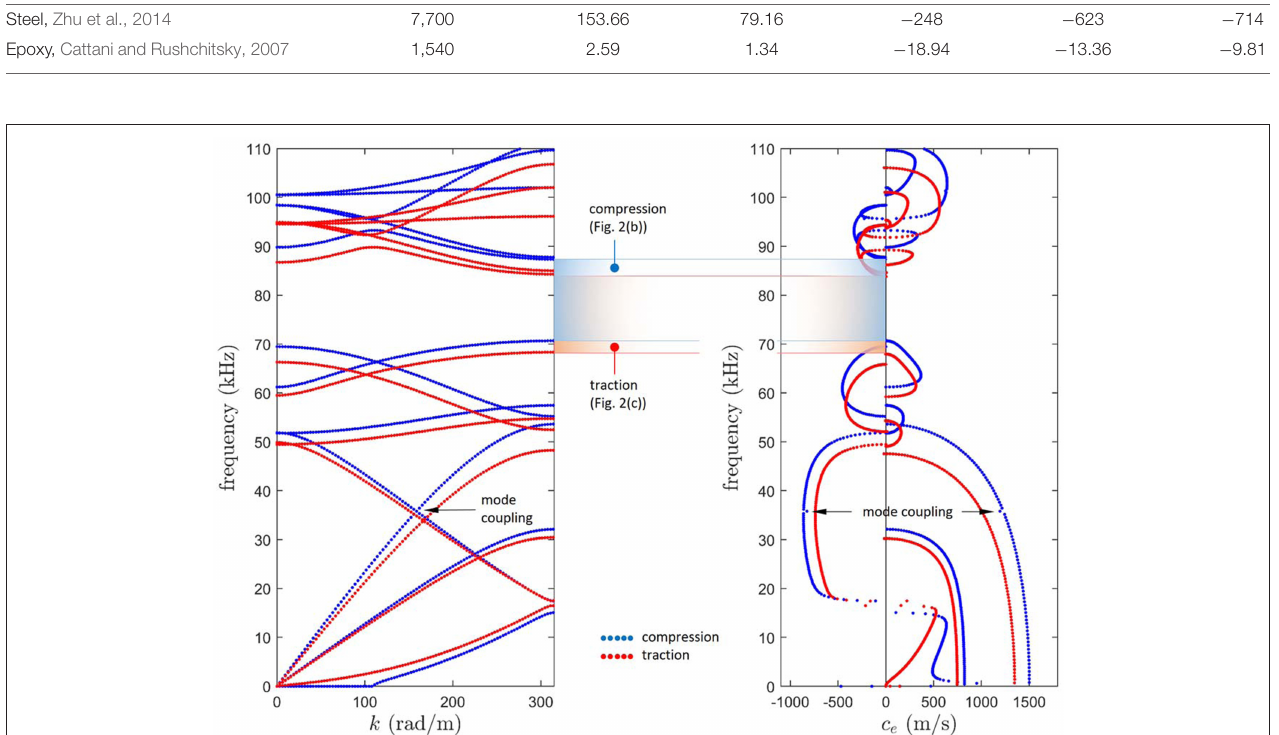
FIGURE 3 | Band diagrams of the wavenumber k (Left) and energy velocity c e (Right) versus frequency for the PC plate under isotropic compression and isotropic traction reported in Figures 2B,C ,